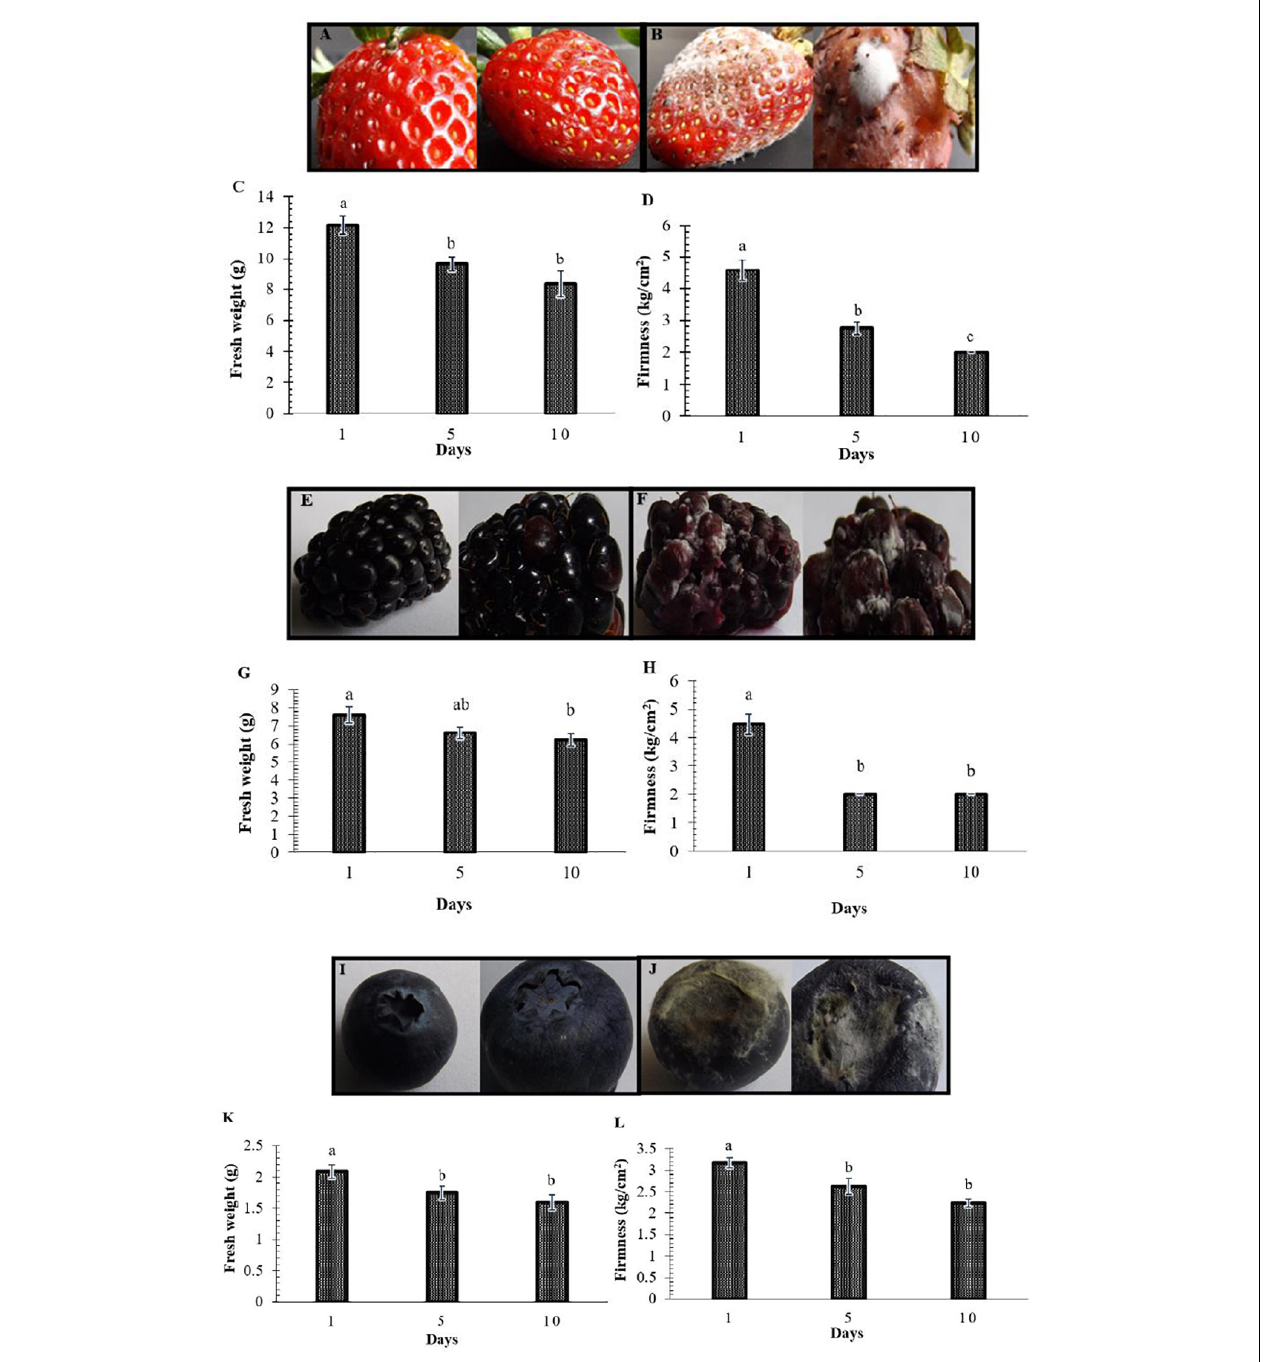
FIGURE 1 | Postharvest decay in berries represented by loss of weight and firmness. Representative fruit are shown in Panels (A,B,E,F,I,J) . (A,E,I) Fruit at the beginning of the study (control). (B,F,J) Fruit in decay on days 5 and 10. Panels (C,G,K) show the decrease in the weight of strawberries, blackberries, and blueberries, respectively. Panels (D,H,L) show the decline in firmness. Bars represent means ± standard deviation ( n = 12). The letters indicate that the means differ significantly according to Duncan’s multiple range test ( p < 0.05).